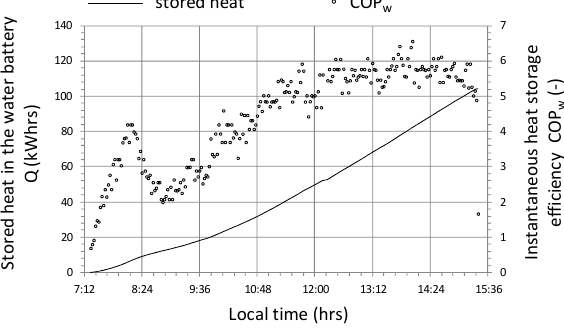
Figure 19. The course of changes in the efficiency of heat storage and the amount of heat stored in cycle No. 1.